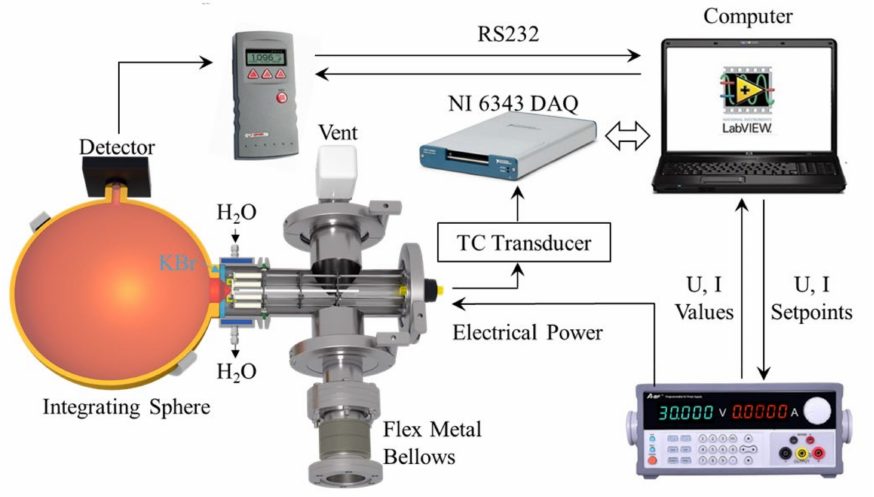
Figure 3. A schematic of the electro-optical conversion (EOC) efficiency measurement mechanism.